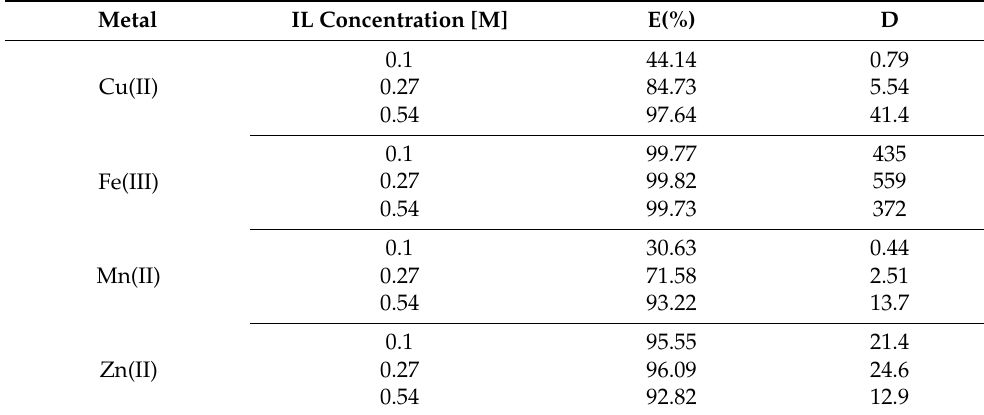
Table 2. Effect concentration of R 4 NCy on extraction efficiency and distribution ratio of the species.